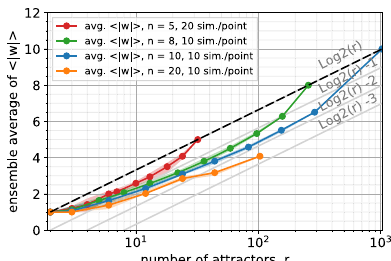
Fig. 7 Distinguishing node set sizes versus number of remaining attractors. Mean minimal distinguishing node set sizes hj w ð 1 Þ empirically less than or equal to log 2 r j in all biological cases we analyze. This consists of 43,289 cases (with 12 sampled